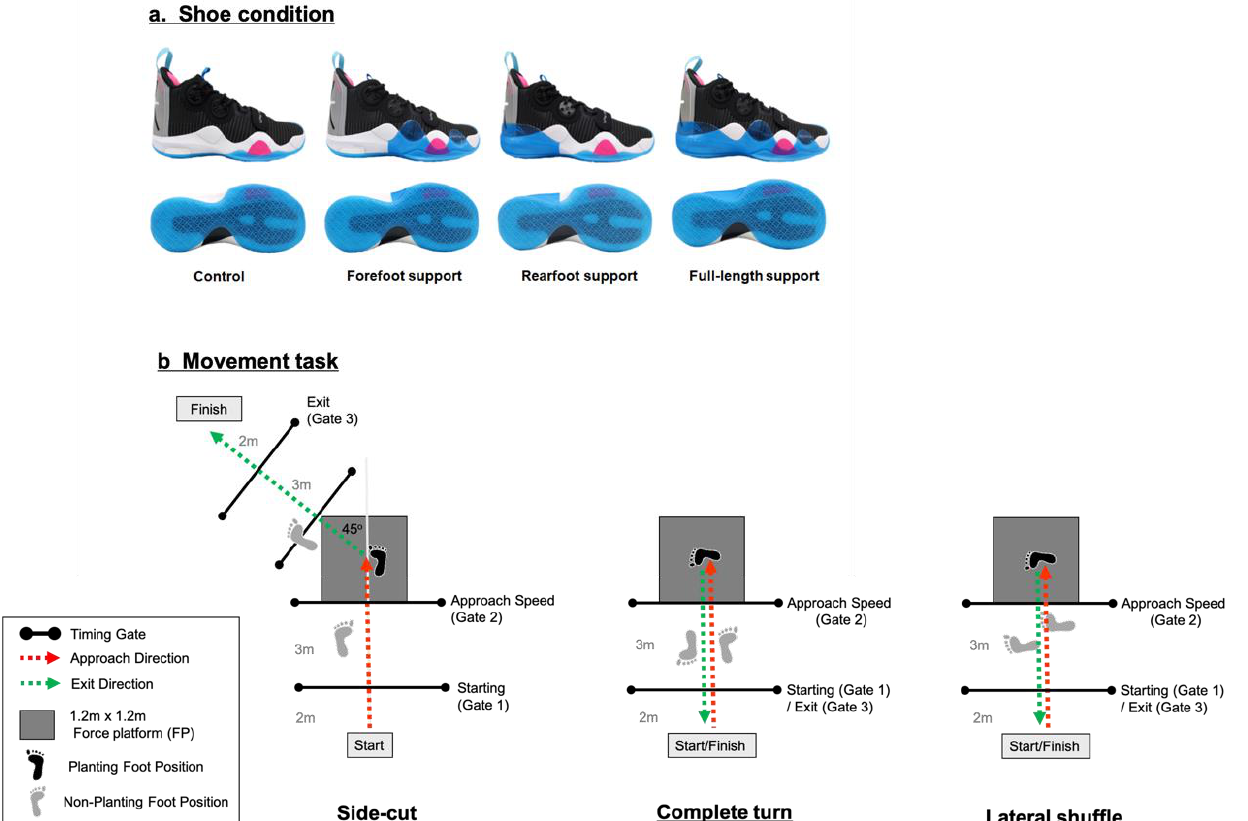
Figure 1. ( a ) Experimental shoe conditions and ( b ) movement courses for side-cut, complete turn and lateral shuffle.